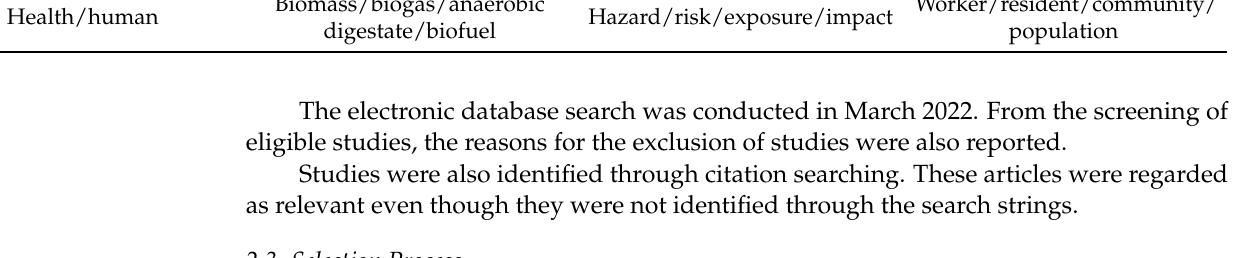
Table 1. Key aspects taken into consideration in the review.